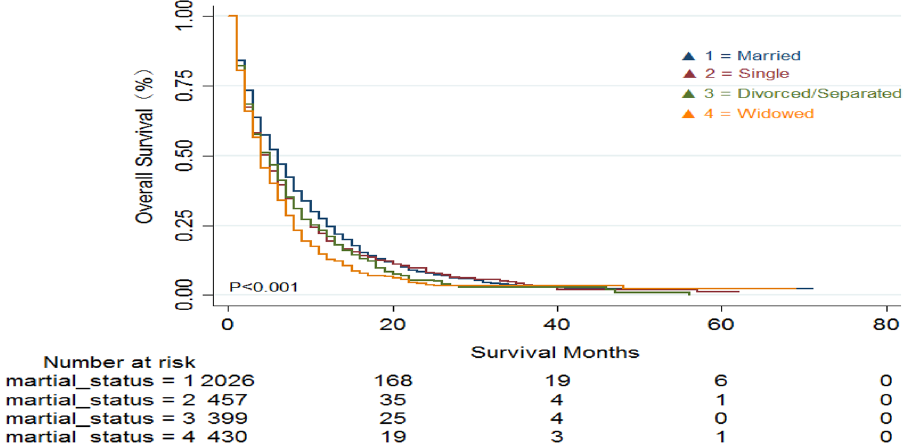
Figure 2. Kaplan–Meier survival analysis of overall survival (OS) in mPDAC patients of different marital status.